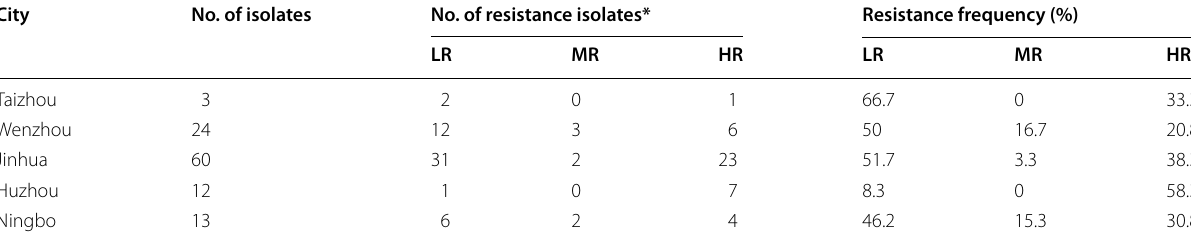
*LR, MR, and HR mean low-, moderate-, and high-level resistance to difenoconazole, respectively